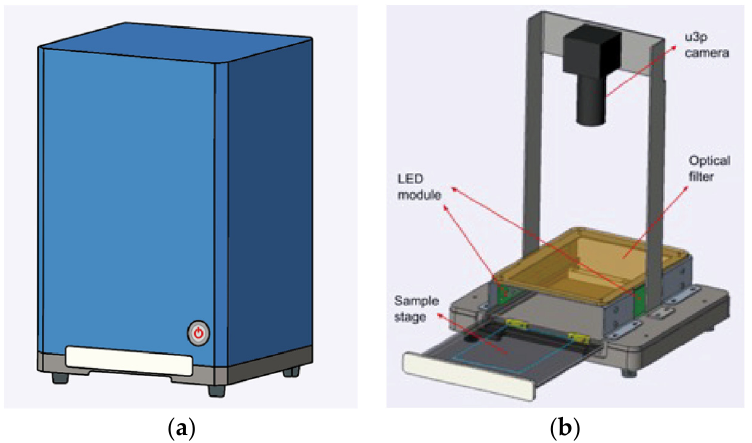
Figure 9. The prototype design of the automated membrane reader . ( a ) Outer appearance of the prototype. ( b ) Interior components of the membrane reader.